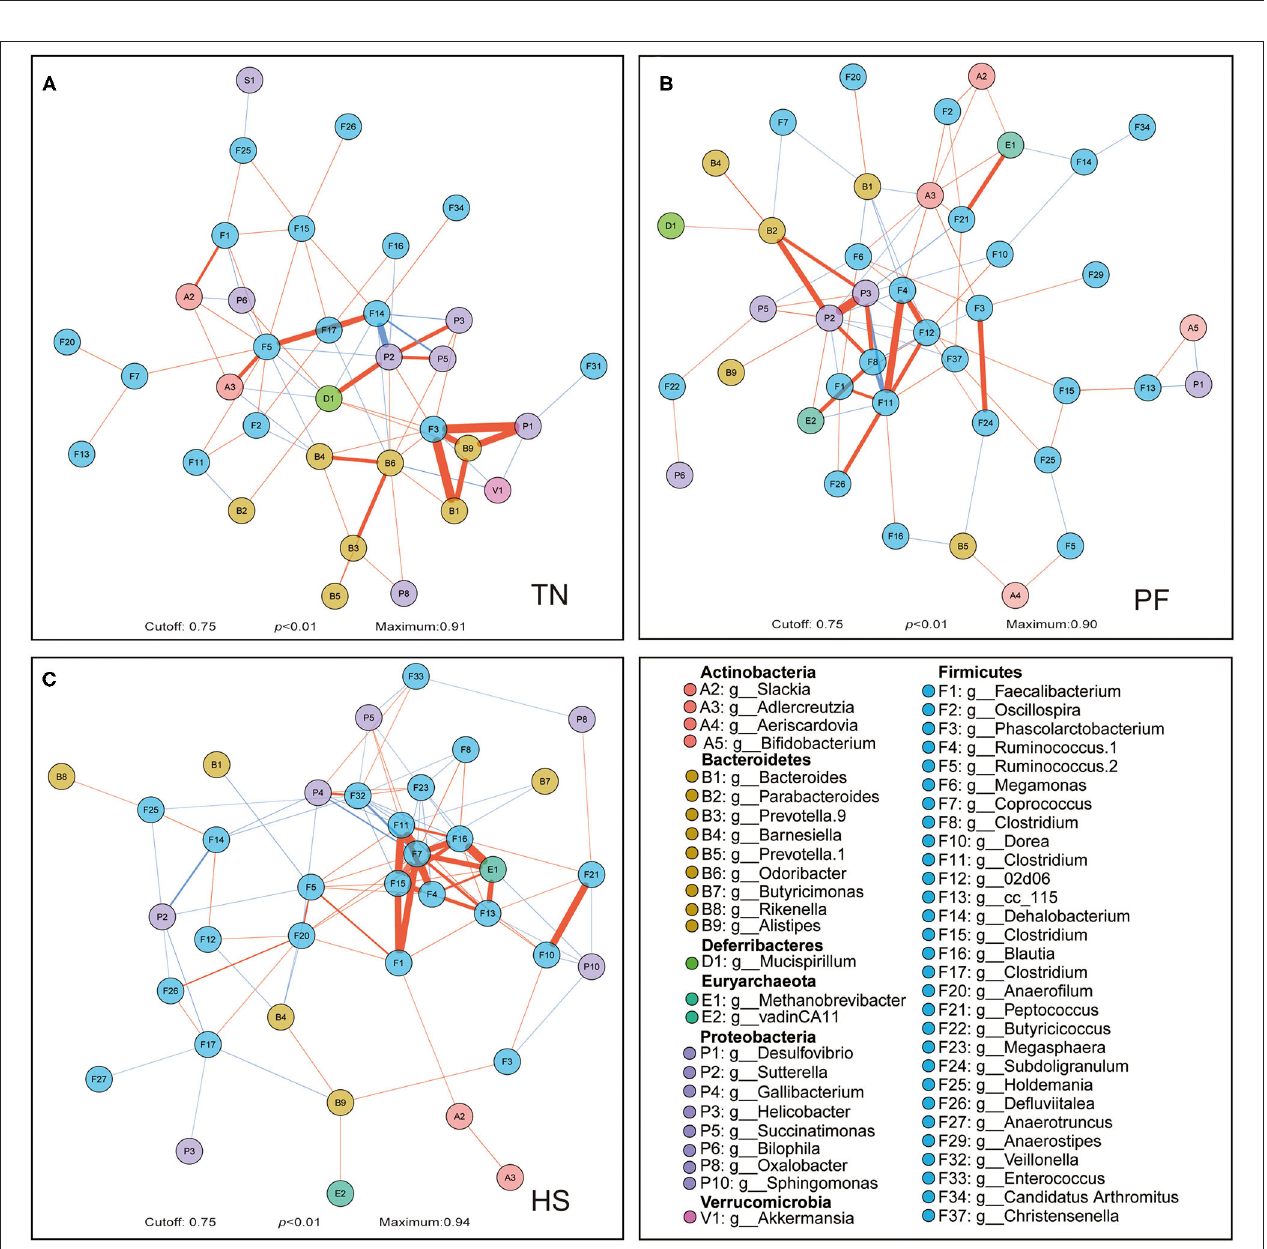
FIGURE 3 | (using false-discovery rate-corrected P -values of 0.01). The stacked bar plots represent the average distribution of bacterial phyla (B) and genera (C) , respectively. A statistical comparison between differences in the relative abundance of dominant microbial phyla (D) and genera (E) among three experimental groups based on Welch’s t -test ( p < 0.05 and effect sizes > 2).